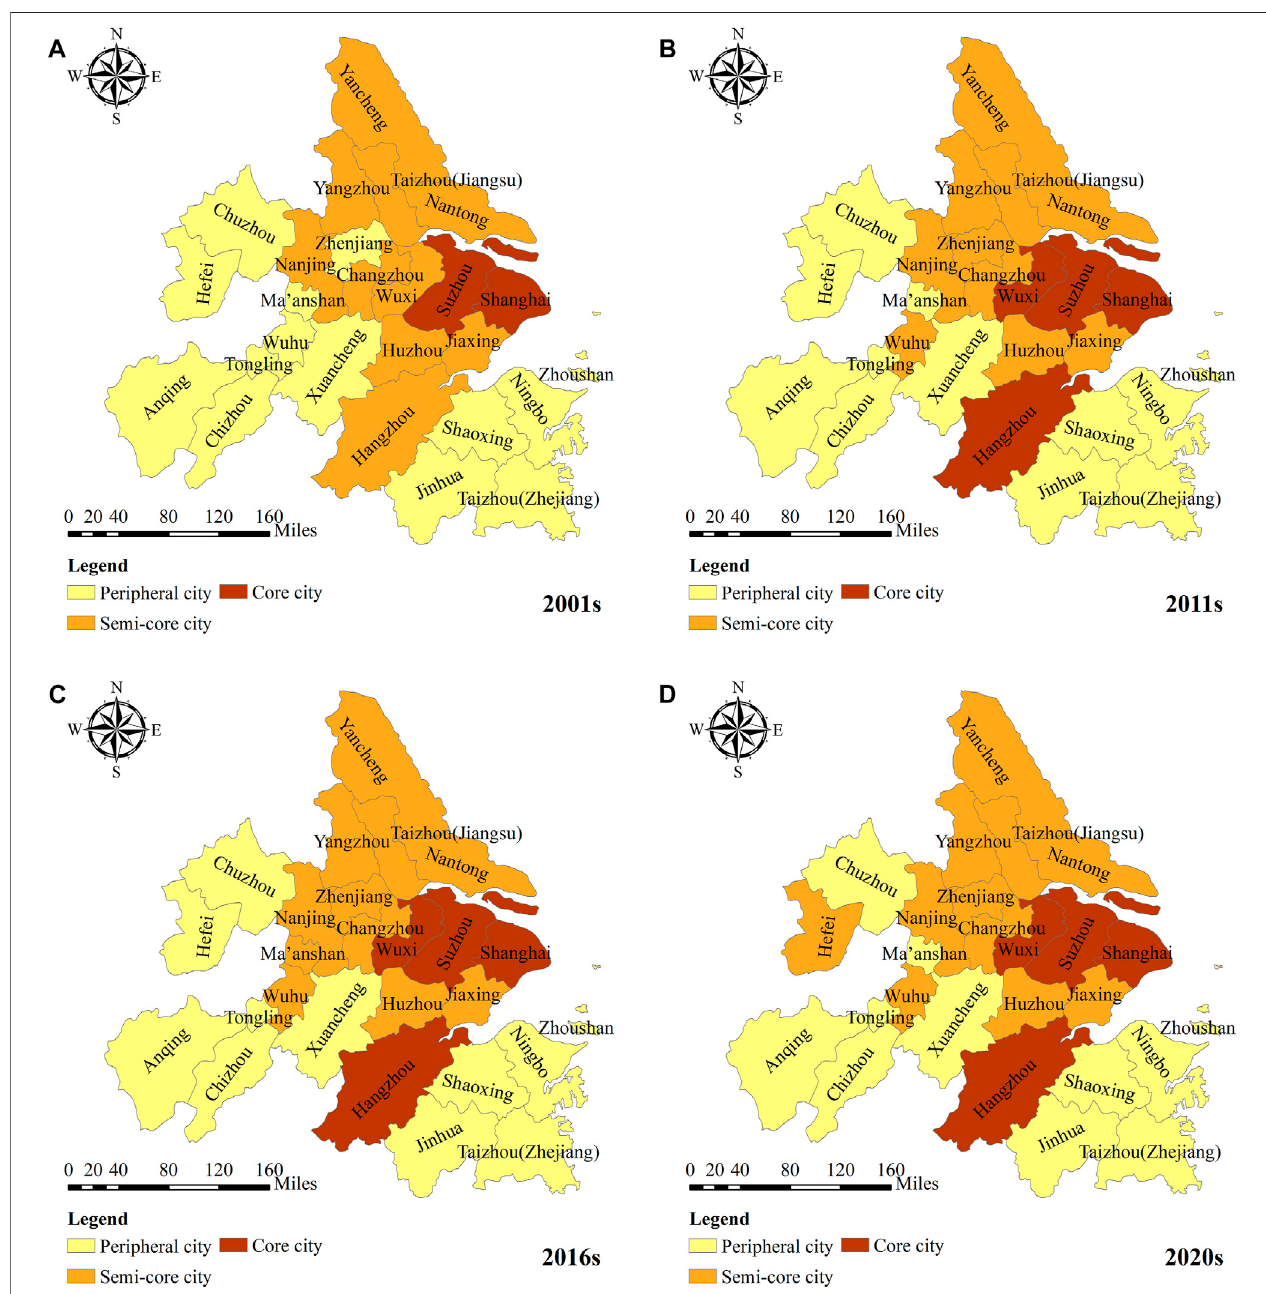
FIGURE 7 | Distribution of core-peripheral structure of water network in the